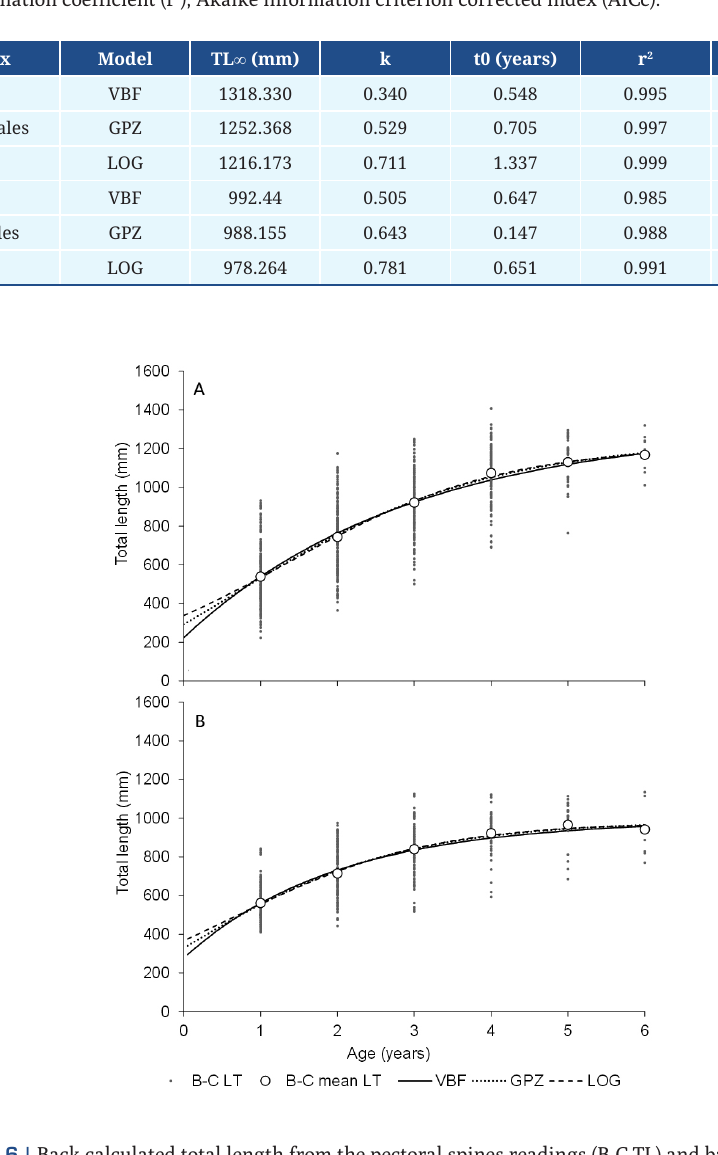
FIGURE 6 | Back calculated total length from the pectoral spines readings (B-C TL) and back calculated mean total lengths at age (B-C mean TL) for Pseudoplatystoma corruscans females ( A ) and males ( B ), and the respective fitted growth models: Von Bertalanffy (VBF), Gompertz (GPZ) and logistic (LOG).